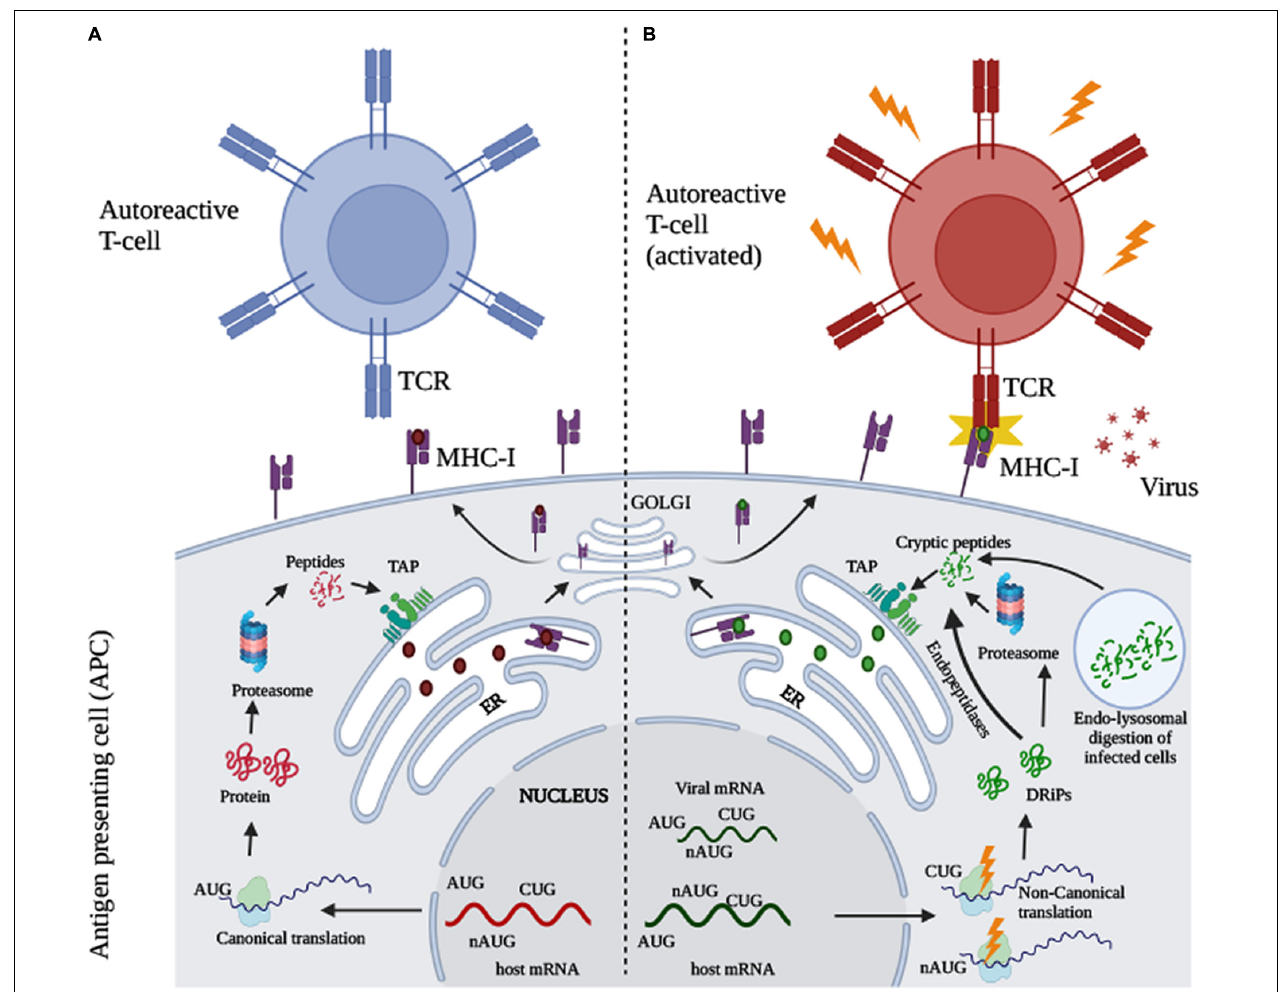
FIGURE 1 | Role of non-canonical translation in virus-induced autoimmunity. (A) Proteins synthesized from canonical open reading frames (ORFs) are degraded via the proteasomal degradation pathway. The peptides produced thereof localize to the endoplasmic reticulum (ER) via TAP and are loaded on MHC-I molecules. The presented complexes however, fail to activate autoreactive T-cells as T cells against a majority of self-peptides are eliminated during the selection process in the thymus. (B) During viral infection, stress responses alter the translational machinery to synthesize novel proteins/polypeptides from both viral and cellular non-canonical ORFs, initiating at non-canonical AUG (nAUG) or other codons (e.g., CUG). These novel proteins are highly unstable and are preferentially degraded via several mechanisms including both proteasomal independent and dependent mechanisms, cytoplasmic endopeptidases and peptides formed through endo-lysosomal digestion of infected cells. The novel cryptic peptides, previously invisible to the immune system can now activate specific T-cell clones triggering an autoimmune-like response (Created using